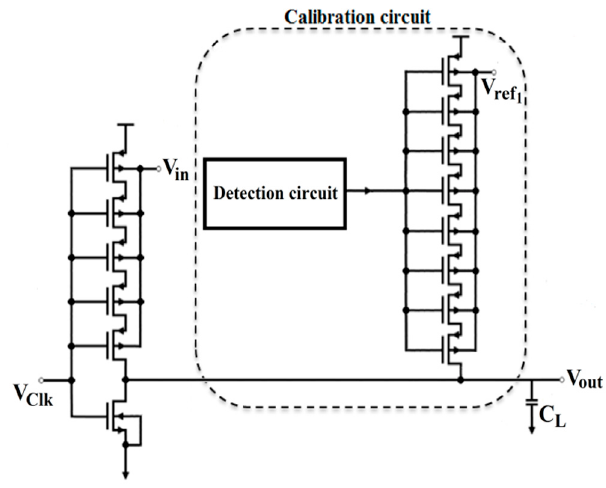
Figure 16. The second proposed VTC with the calibration circuit.